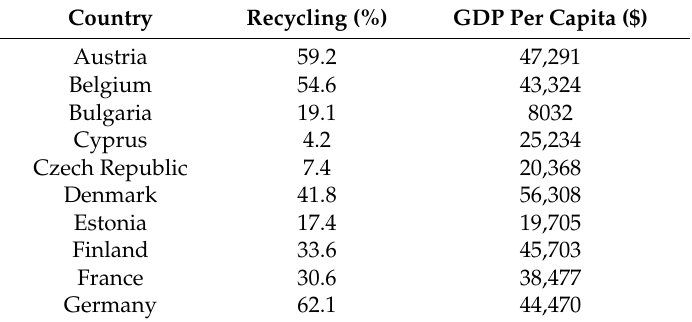
Table 1. Recycling rate and economic growth of the EU